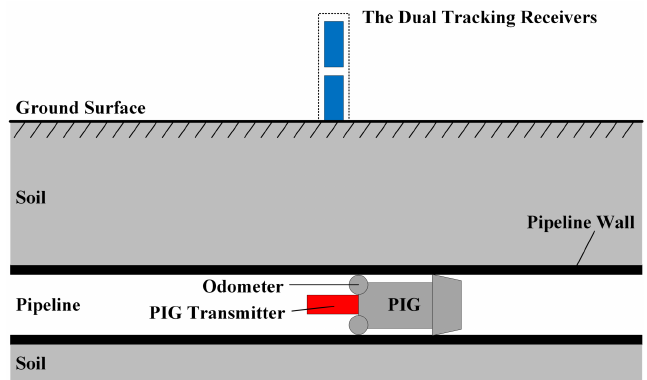
Figure 1. The architectural overview of the dual receivers tracking system. The red cylinder represents Pipeline inspection gauge (PIG) transmitter, while blue ones are tracking